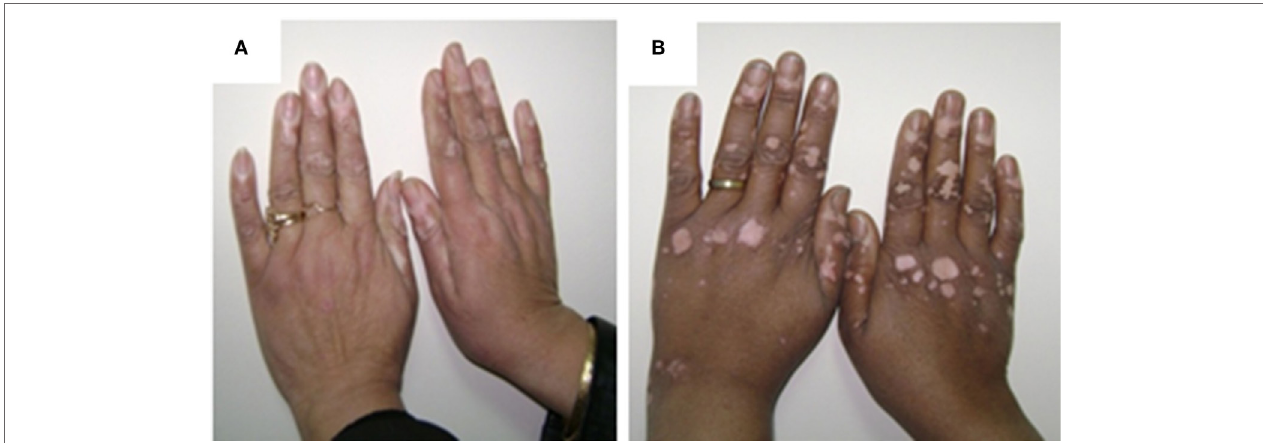
FigUre 1 | The pictures of female patient, 33 years old showing acral active vitiliginous lesions in both hands (a) and female patient, 40 years old showing acral stable vitiliginous lesions in both hands (B) . The written informed consent obtained from the participants for publication of the images in this